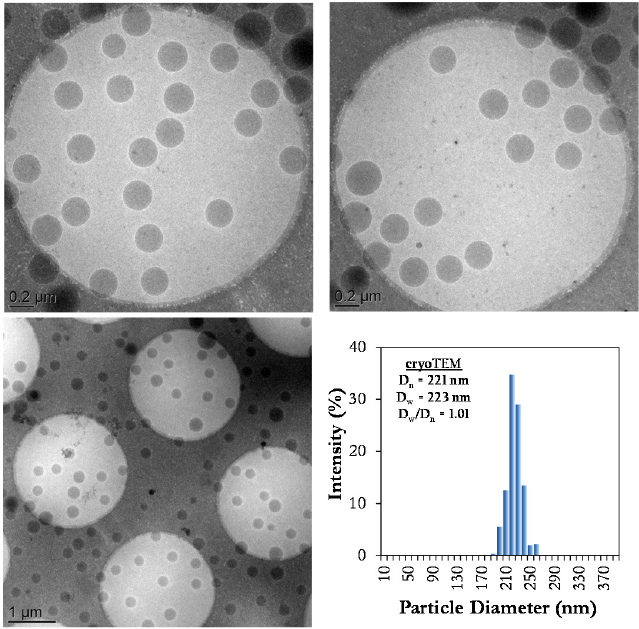
Figure 4. Cryo-TEM images and corresponding size distribution histogram of HD-SBR#01.